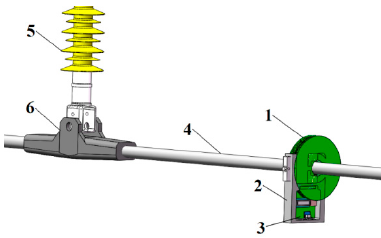
Figure 4. Non-contact open-type voltage sensor.